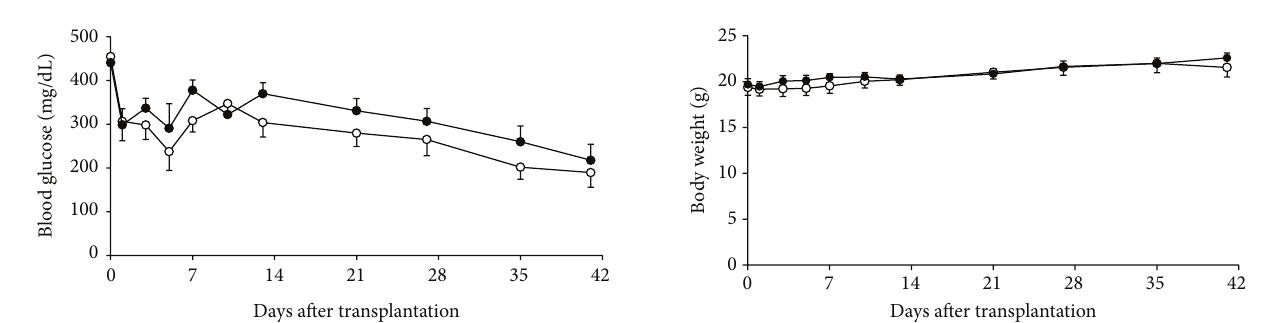
Figure 1: Blood glucose changes in islet recipients with (solid circle) and without (open circle) MK-0431 treatment.